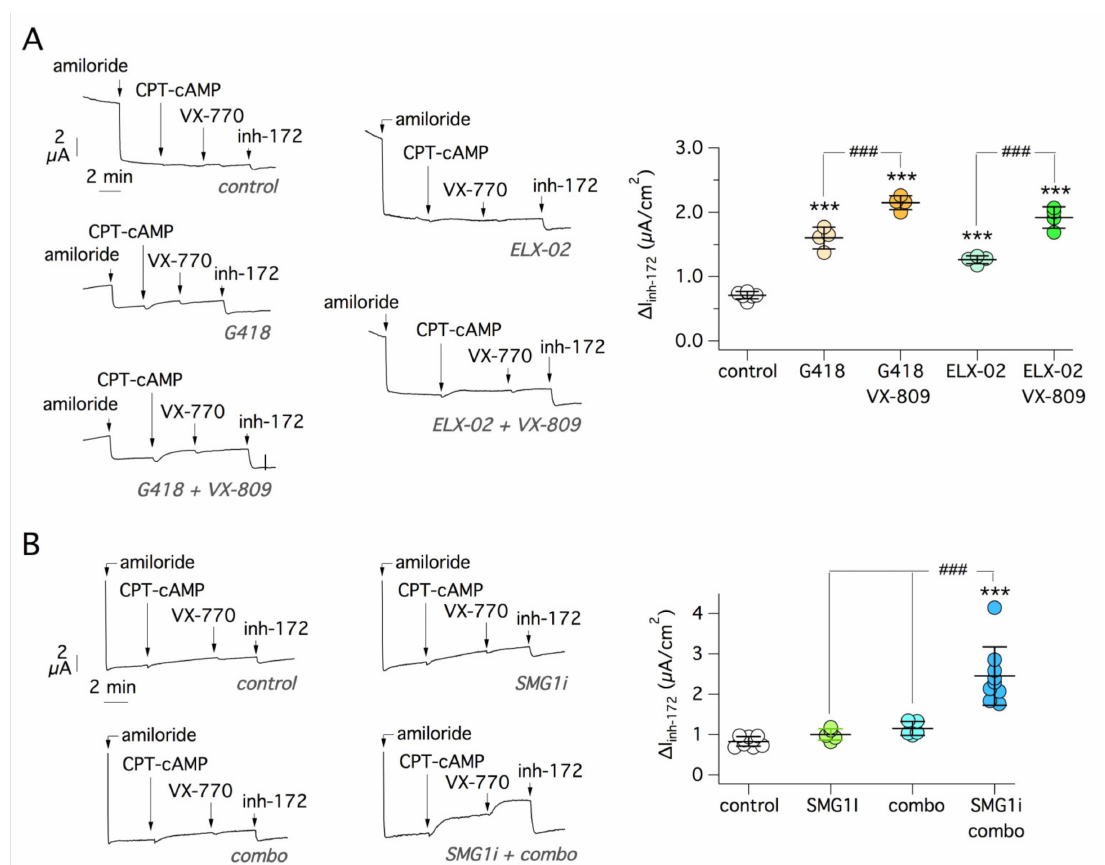
Figure 11. Evaluation of mutant CFTR rescue in native bronchial epithelial cells. ( A ) Short-circuit current traces (left) and summary of data (right) obtained from bronchial epithelial cells of a G542X/1717-1G > A patient. Epithelia were treated with the indicated compounds (0.5 mg/mL G418 and ELX-02, 1 µ M VX-809). ***, p < 0.001 vs. control. ###, p < 0.001 vs. readthrough agent alone. ( B ) Short-circuit current traces (left) and summary of data (right) obtained from bronchial epithelial cells of a W1282X/W1282X patient. Epithelia were treated with the indicated compounds (1 µ M SMG1i; 1 µ M VX-809; 5 µ M VX-445). The amiloride-sensitive currents in the traces were left out of scale to allow a better vision of CFTR currents. ***, p < 0.001 vs. control. ###, p < 0.001 vs. indicated